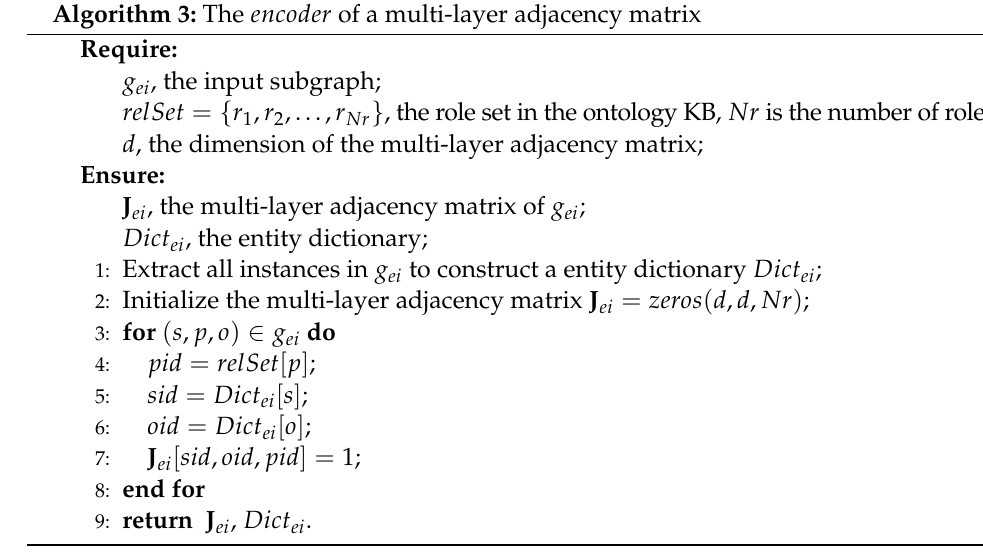
Algorithm 3: The encoder of a multi-layer adjacency matrix